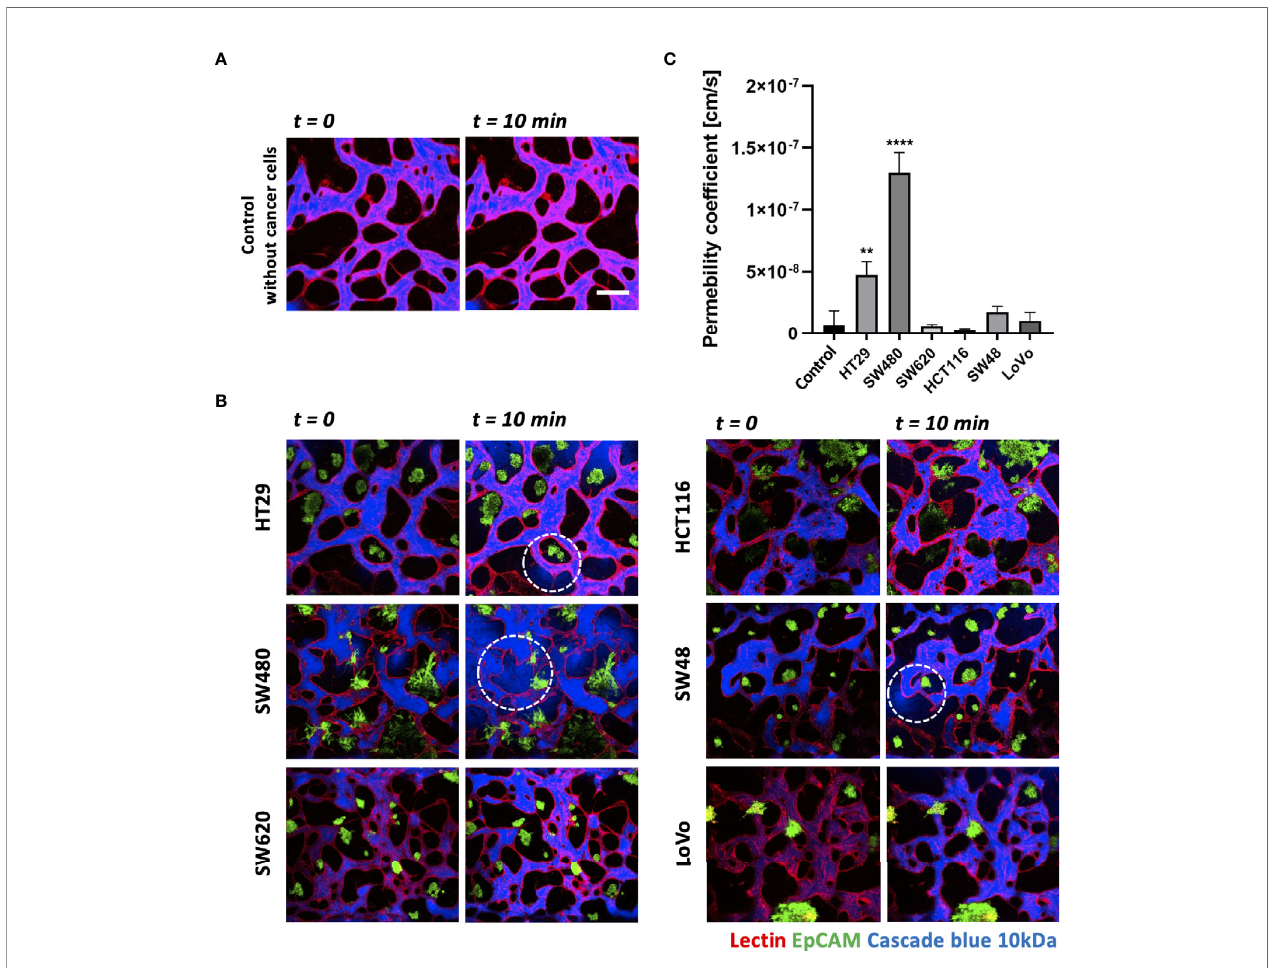
FIGURE 4 | Vascular permeability of normal and tumor vasculature. (A) Time-lapse 3D confocal images of normal vasculature. Cascade blue (MW = 3kD) was used to measure vascular permeability. (B) Time-lapse 3D confocal images of tumor vasculature. Blood vessels and CRC cells were labeled with lectin (red) and EpCAM (green), respectively. The blue fl uorescent dye leaked from weak tight junctions on the vascular wall marked by a white dashed circle. (C) Plot of relative permeability coef fi cients. HT29 and SW480 were more permeable than other conditions (n = 6 for each condition). **p < 0.01; ****p < 0.0001. Scale bar = 200